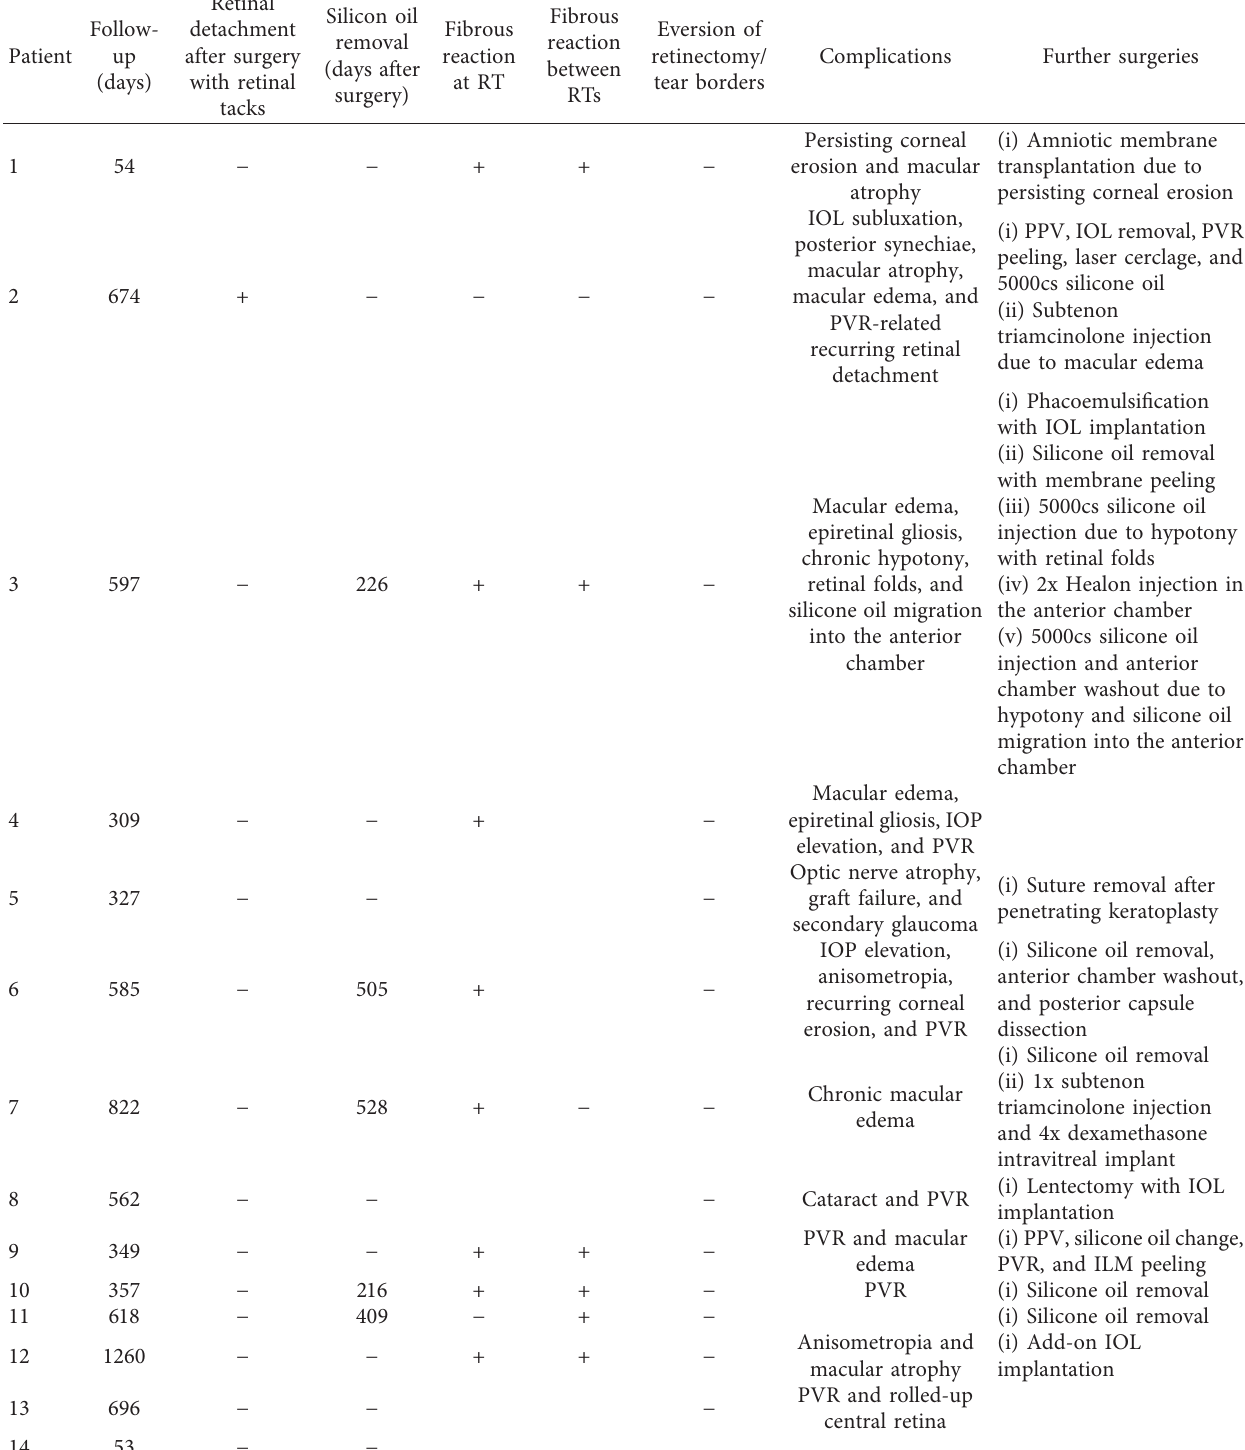
Table 4: Complications and additional